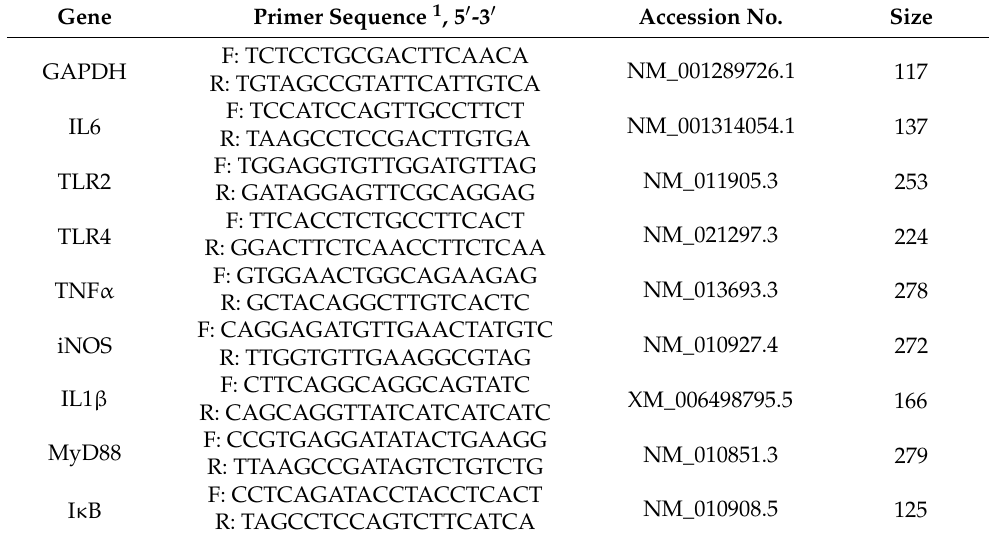
Table 2. Primers used in this